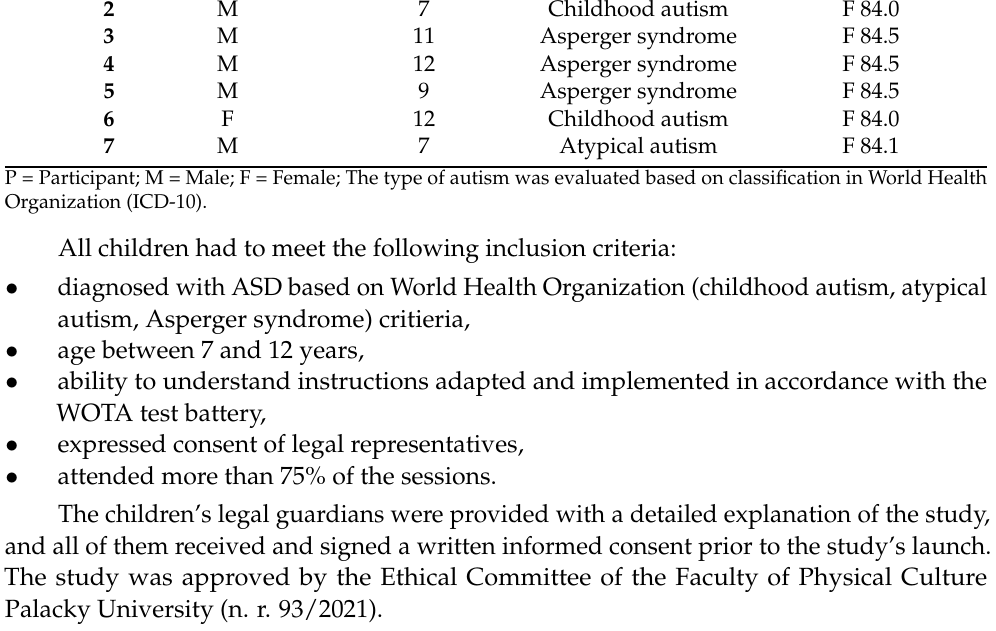
Table 1. Research subject by gender, age, and type of autism. P M/F Age Type of Autism Code of Diagnosis 1